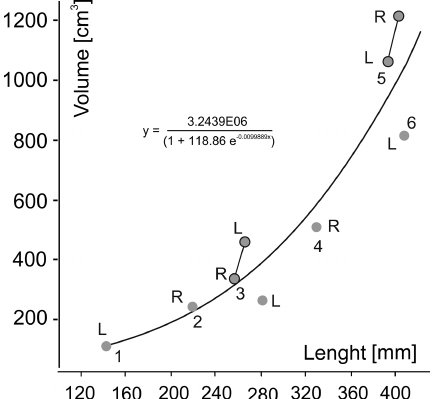
Figure 8. Logistic function showing the relation between center line length and shell volume based on empirical measurements of nine shells (dots); L = left shell, R = right shell; shell pairs are linked; numbers correspond to specimens illustrated in Fig.